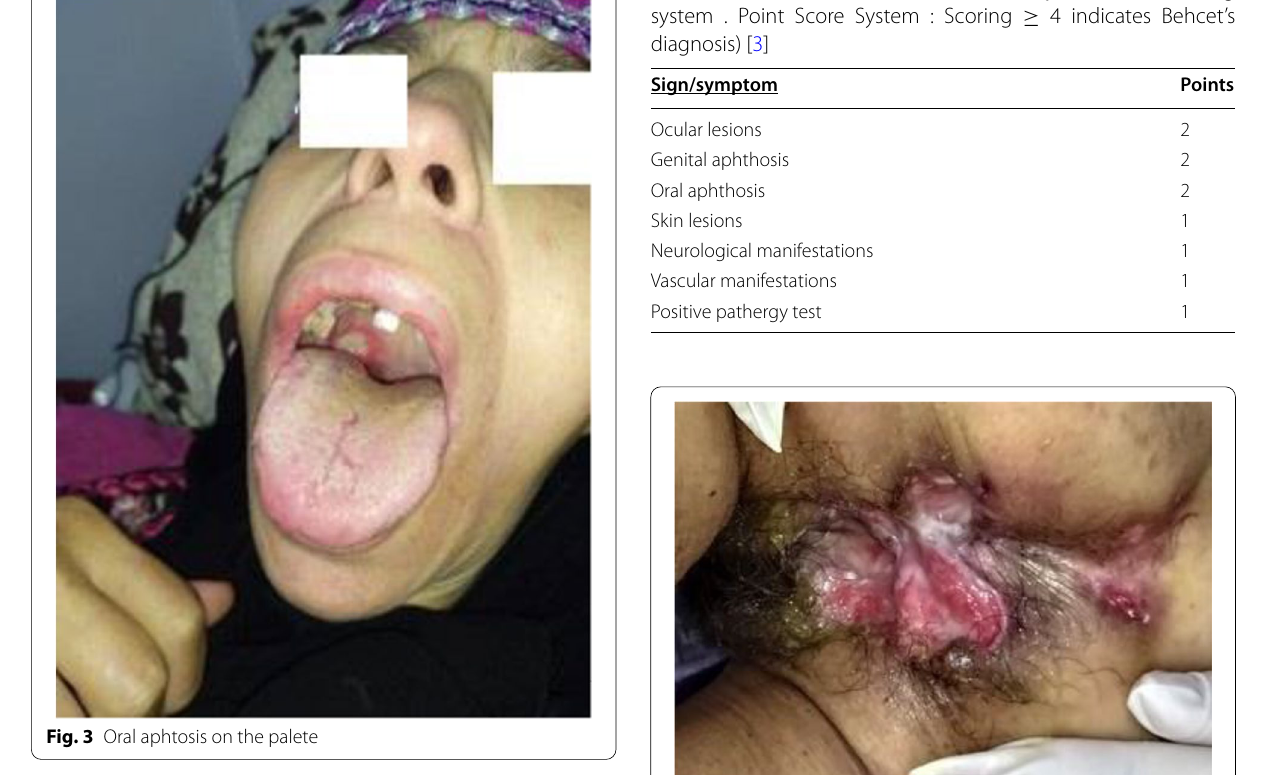
Table 1 The international criteria for Behçet’s disease scoring system . Point Score System : Scoring